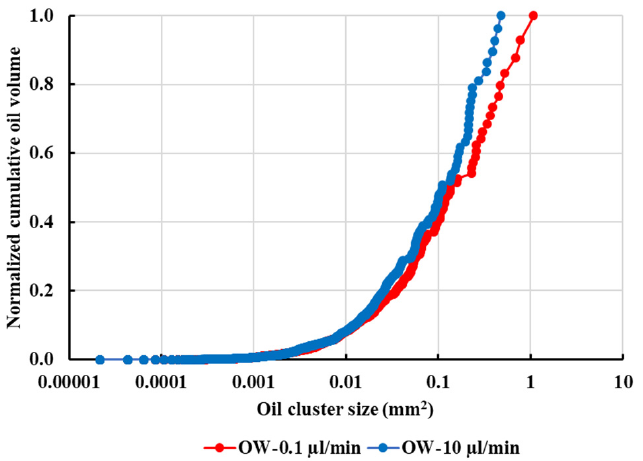
Figure 6. Response in cluster size distribution due to increasing the flow rate of SSW injection from 0.1 µL/min to 10 µL/min. Note: There was no change due to the increase from 0.1 µL/min to 1 µL/min.